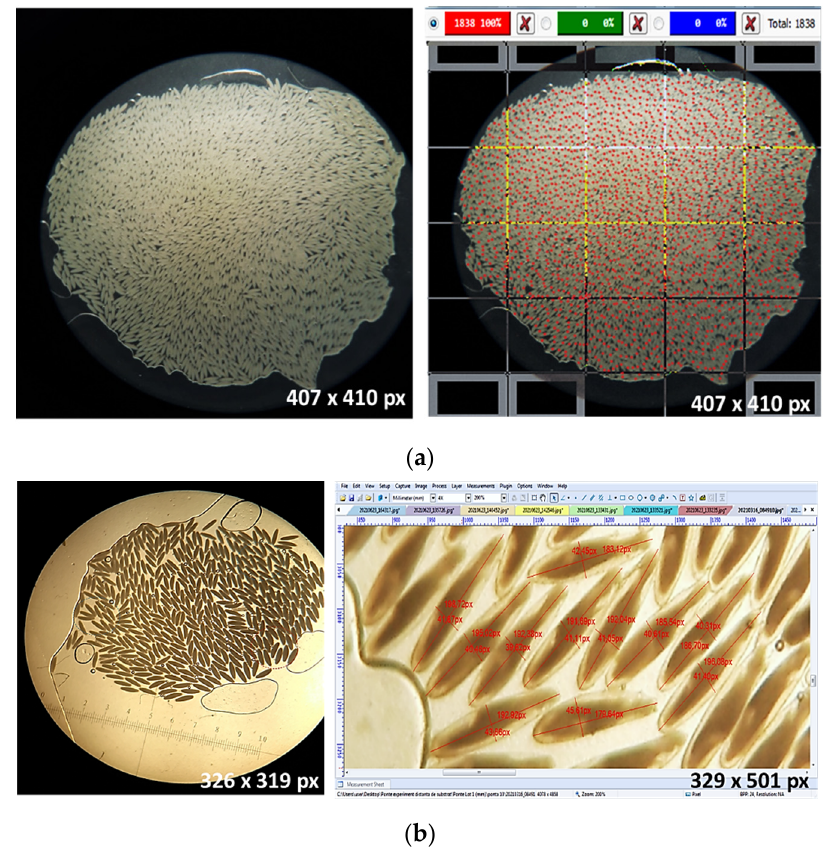
Figure 1. Evaluating the egg clutch of Hermetia illucens (<6-old): ( a ) dispersion eggs from the clutch and counting byClickMaster software; ( b ) evaluation of the egg length and width by Toupview software (red bars = length and width of egg).